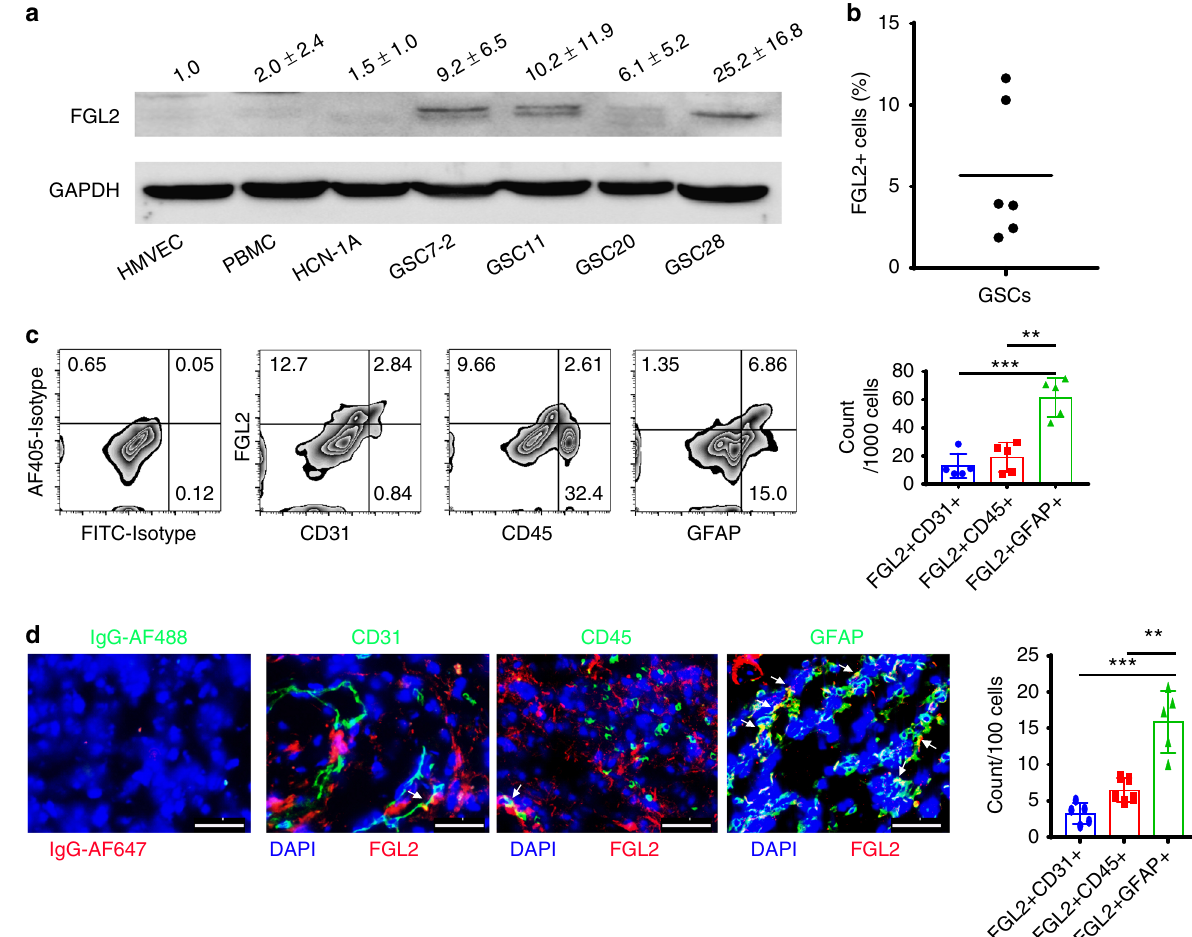
Fig. 1 FGL2 is expressed by glioma cells. a FGL2 protein levels were detected by western blot in human peripheral blood monocytes (PBMCs) from healthy donors, normal endothelial cells (HMVECs), normal neurons (HCN-1A), and four glioma stem cell lines (GSC7-2, GSC11, GSC20, and GSC28). Western blots shown are representative, and quantities are summarized as ratio changes from three independent experiments. Glyceraldehyde 3-phosphate dehydrogenase (GAPDH) was used as a protein-loading control. b Percentage of FGL2 + cells in cultured human GSCs. c Representative fl ow cytometry plots of FGL2 expression on CD45 + , CD31 + , or GFAP + cells from tumors of patients with newly diagnosed GBM. Data ( n = 5) are presented as the mean ± S.D. and analyzed by one-way ANOVA. d Sections of clinical GBM samples were double stained for co-expression of FGL2 (red) and GFAP (green), or of FGL2 (red) and CD45 (green), or of FGL2 (red) and CD31 (green). Nuclei were counterstained with DAPI (blue). White arrows point to co-localization. Scale bars, 50 μ m. Data are presented as the mean ± S.D., and representative images are shown ( n = 5). A one-way ANOVA was used to calculate the two-sided P values. Signi fi cant results were presented as ** P < 0.01, *** P